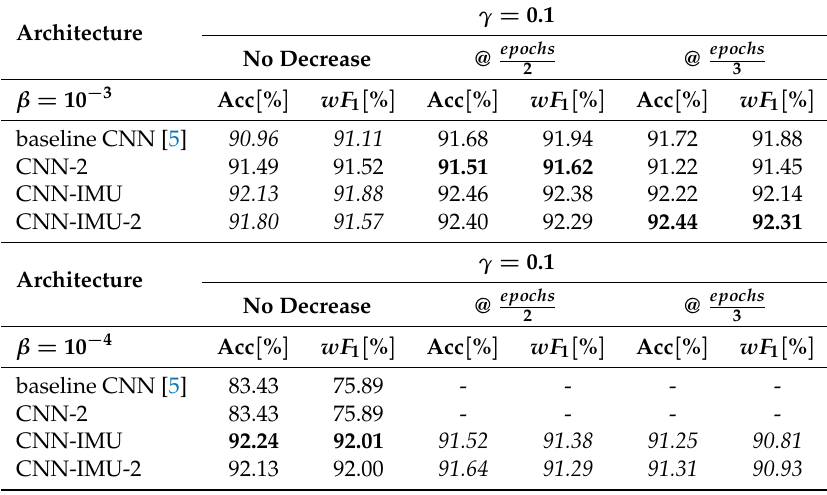
Table 5. Validation accuracies and Weighted F1 for the architectures on the Opportunity-Gestures dataset when reductions of the learning rate at training are used. CNN & CNN-2 architectures with γ = 10 − 4 overfits to the Null class with zero predictions of the other action